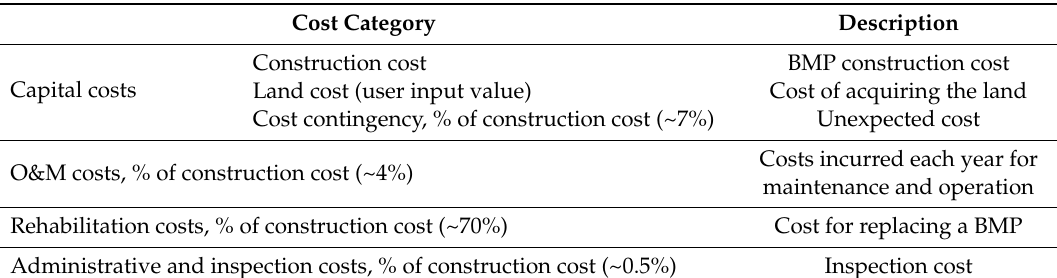
Table 3. Cost categories during the life cycle of the